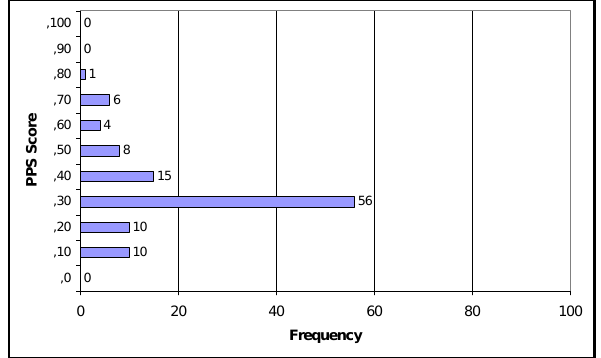
Figure 1: Frequency and distribution of patients according to the PPS Score (n=100)